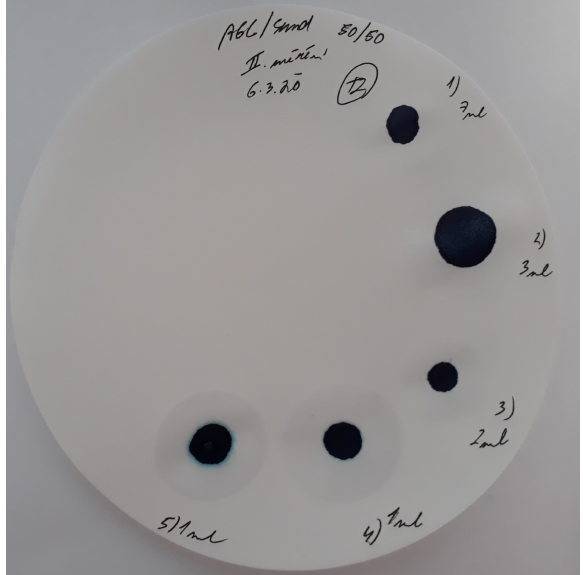
Figure 5. Drops of MB solution with the suspension on a filter paper.